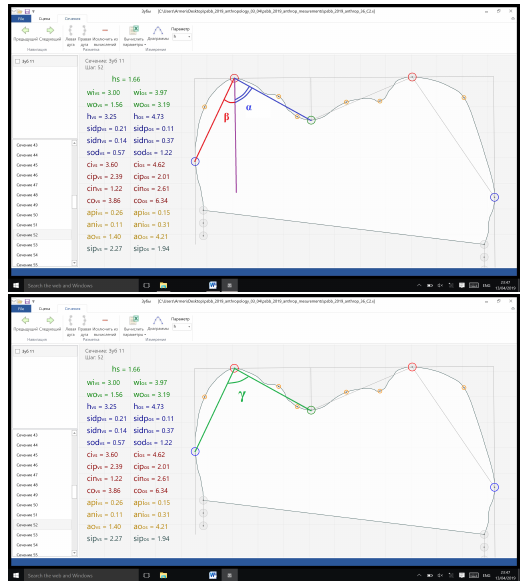
Figure 10. Cusp slope inclination and cusp tip angles on tooth contour slope inclination angles on 3.6,C2 and